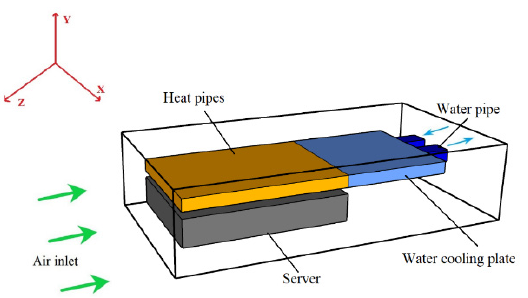
Figure 6. The cooling method of the combined HPEs for a single server in the rack.